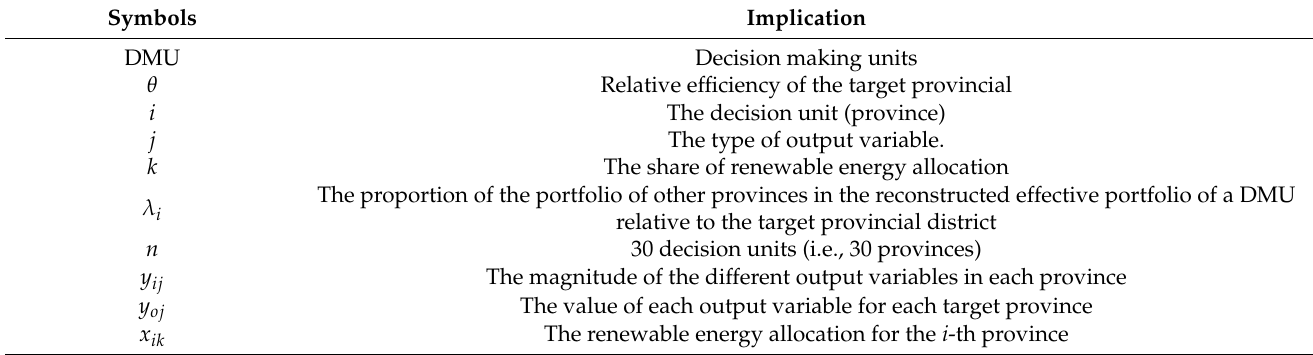
Table 3. Summary